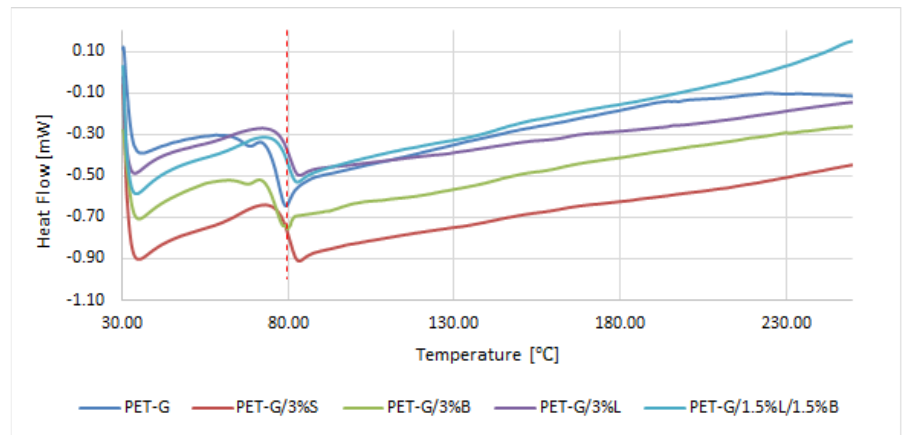
Figure 9. Results of the differential scanning calorimetry (DSC) analysis of PET-G and PET-G composites.